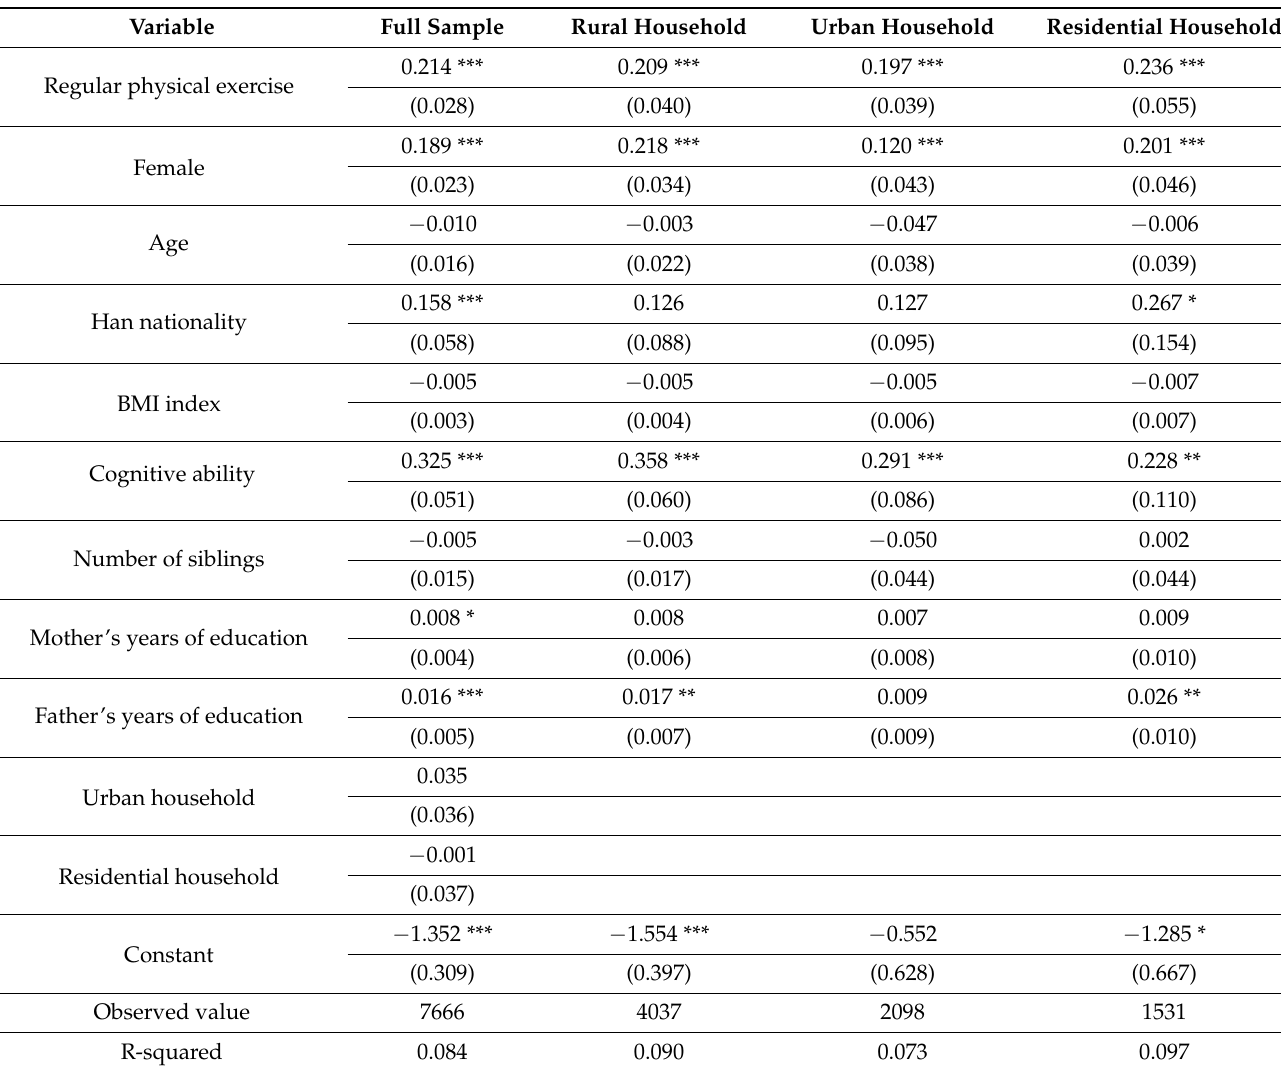
Table 2. OLS estimation